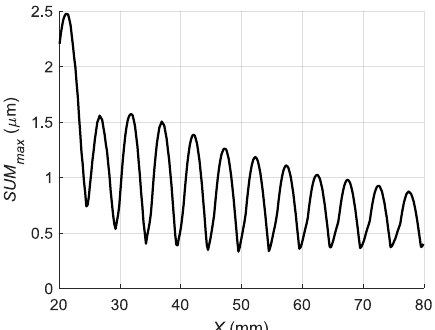
Figure 18. Spatial distribution of the peak values of the normal displacements of the PVC film along x -axis taking into account the wave propagating in air.